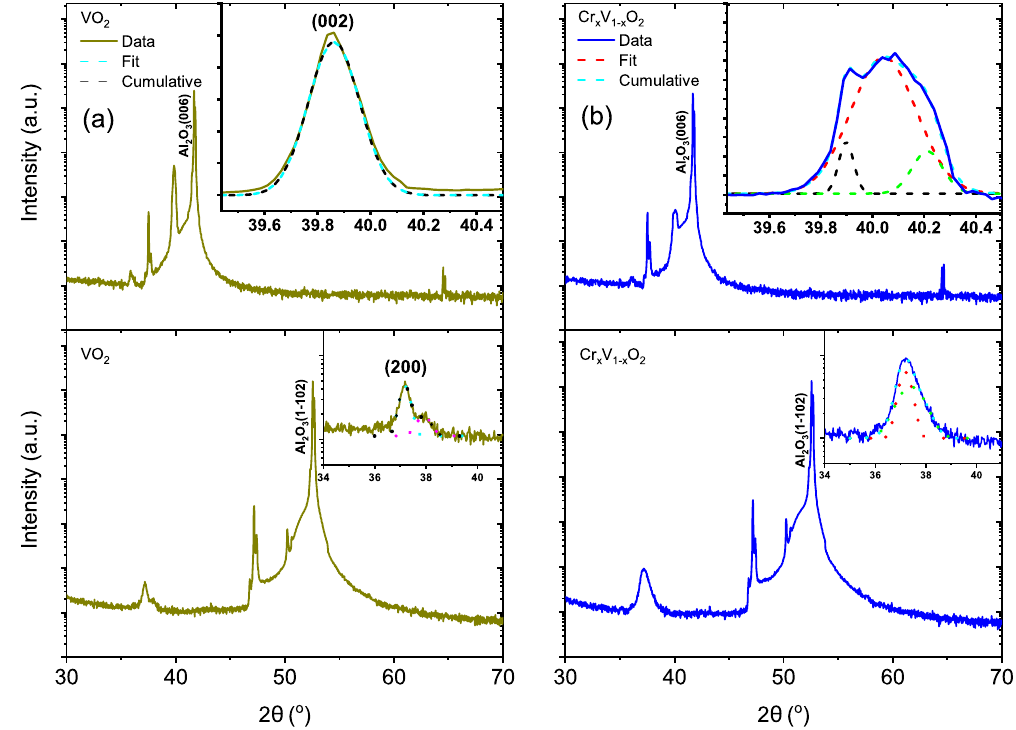
Figure 1. θ − 2 θ scans of undoped ( a ) and Cr-doped VO 2 ( b ) films deposited on c- and r-plane sapphire substrates with their respective insets showing the main peak